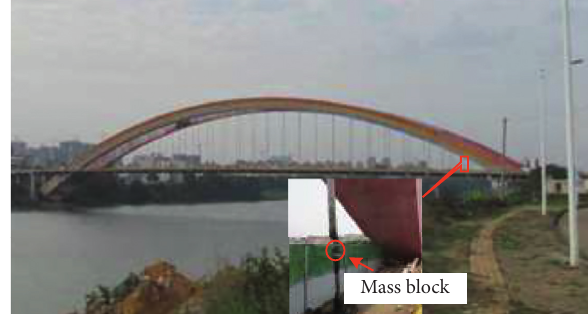
Figure 8: Pumiao